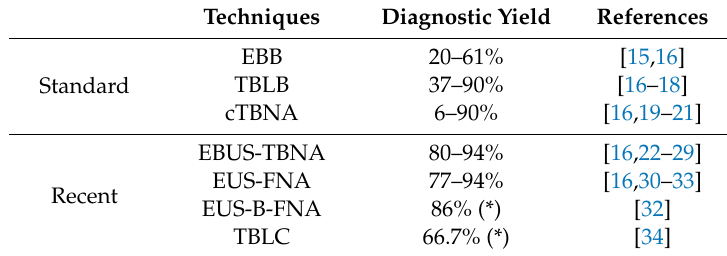
Table 1. Bronchoscopic techniques to diagnose sarcoidosis and their overall diagnostic